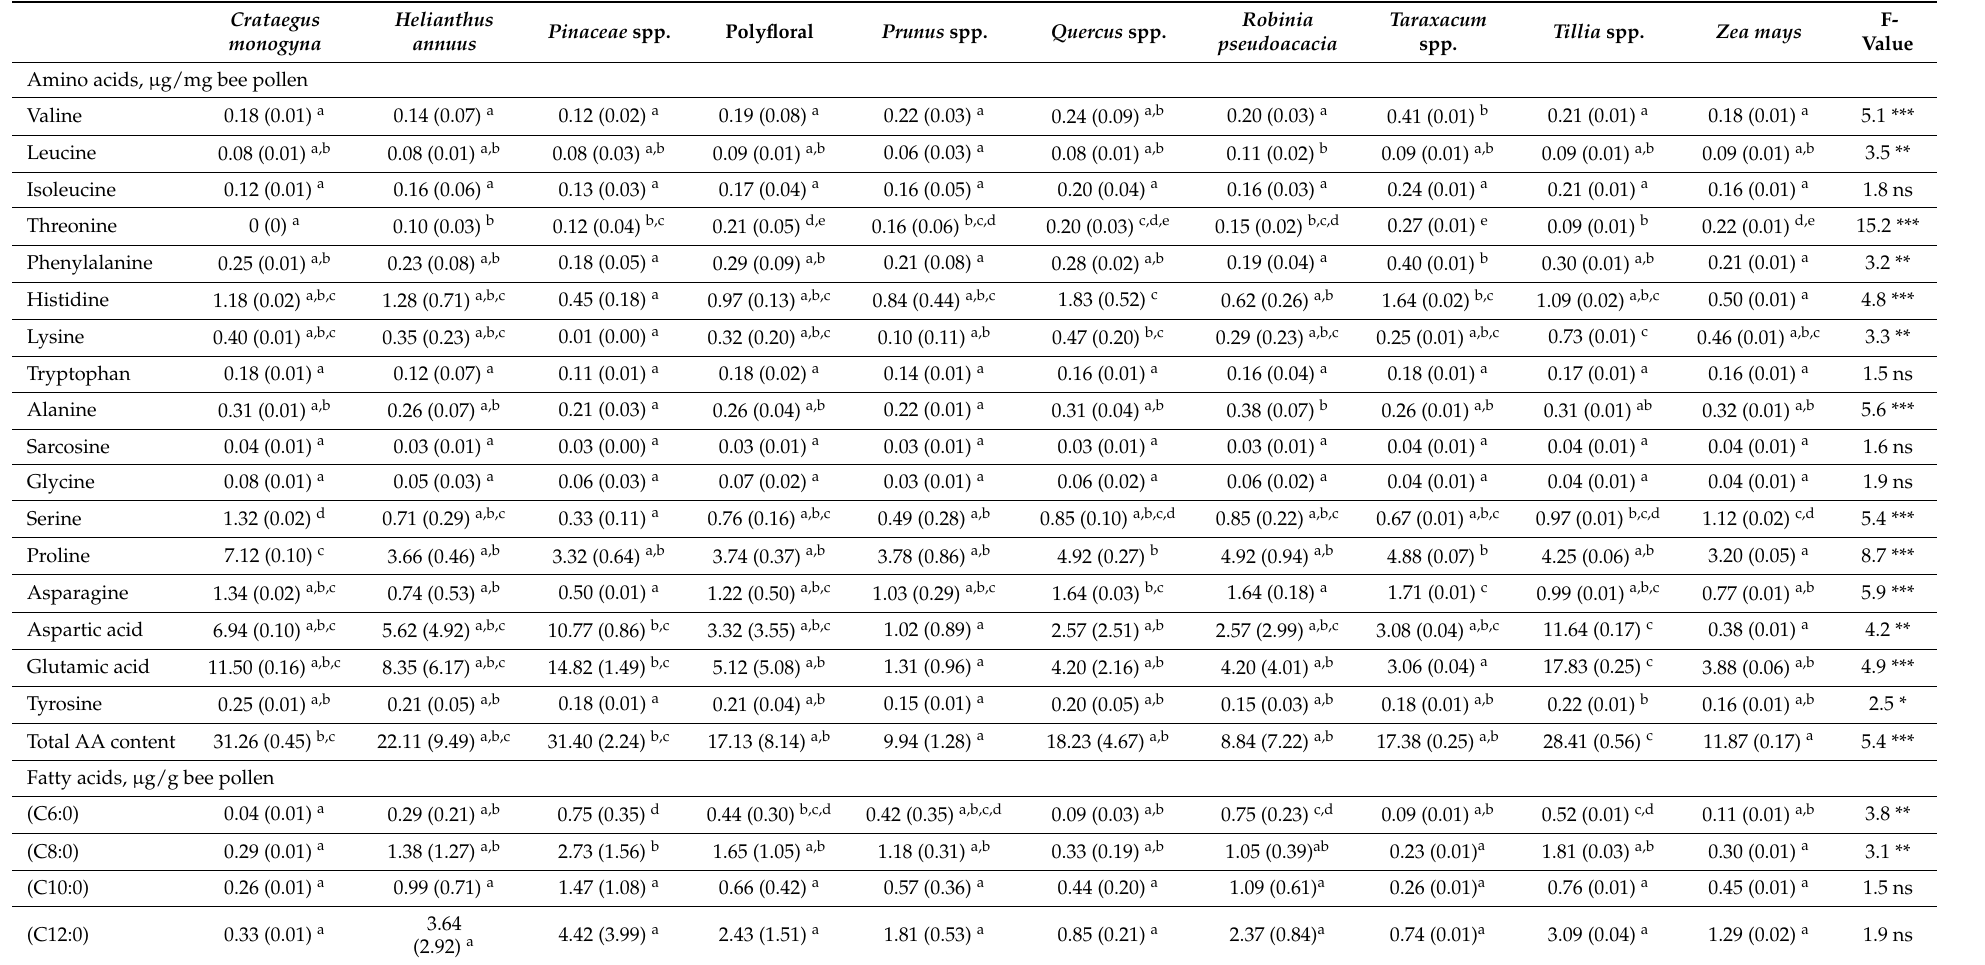
Table 4. Amino acids profile and fatty acids composition of bee pollen (mean values and standard deviation in brackets). Crataegus